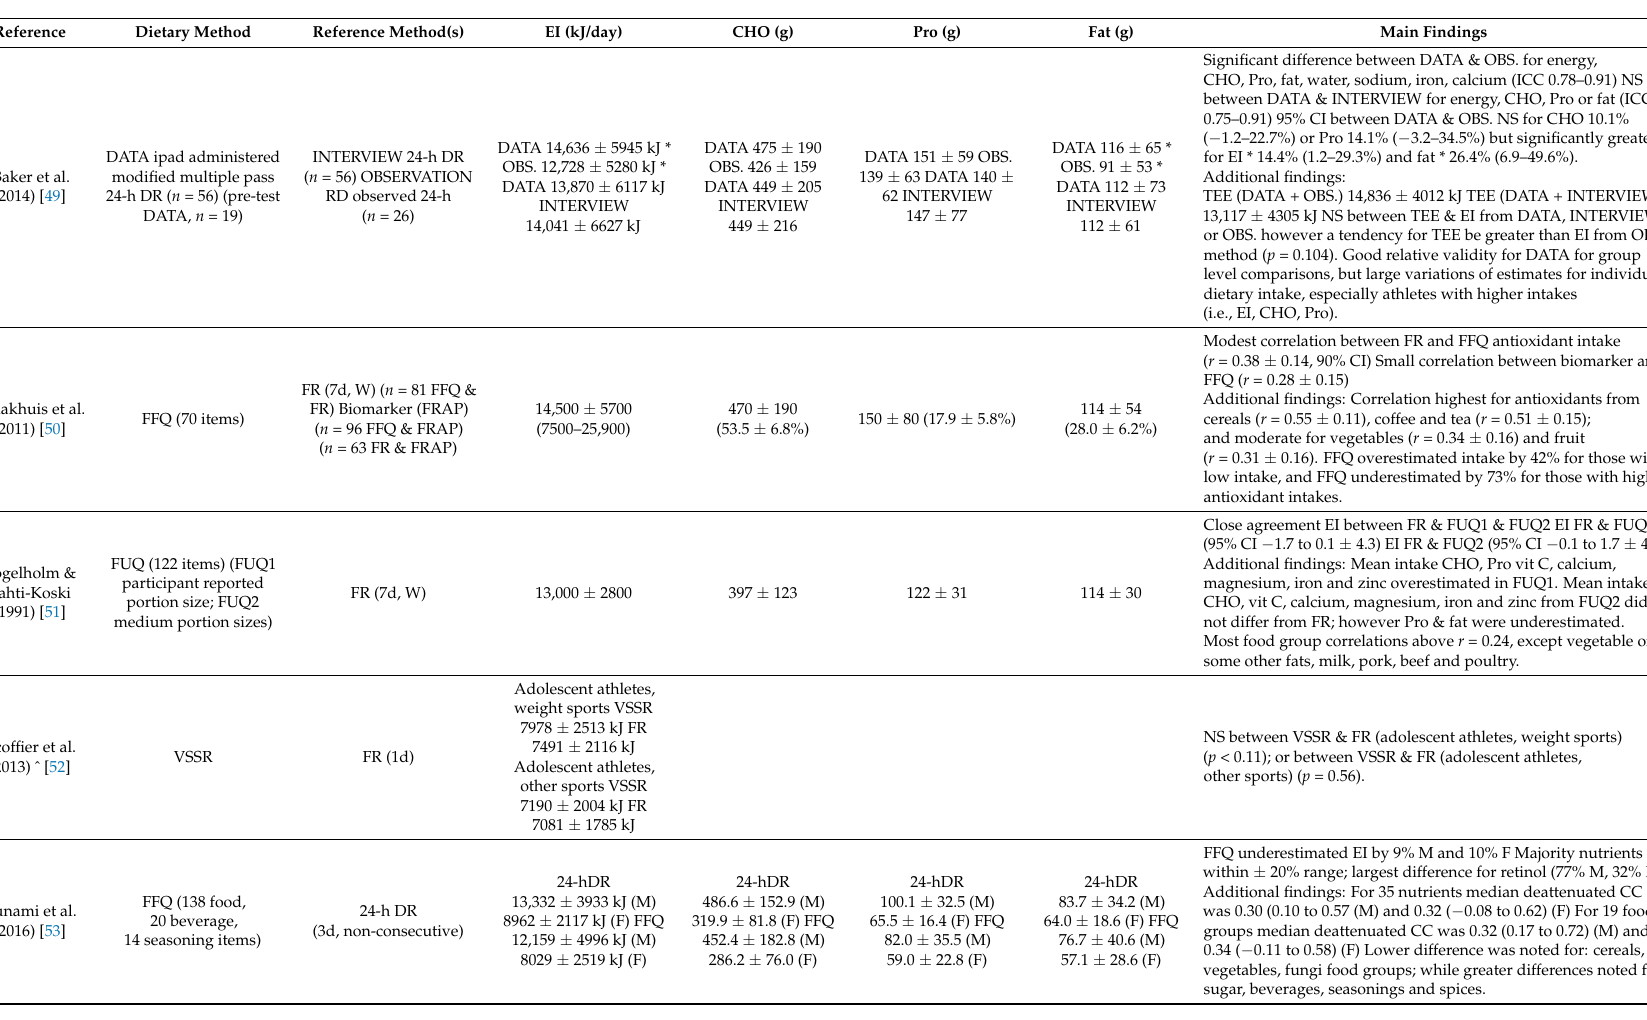
Table 4. Studies comparing reported dietary intake as measured by two or more methods of dietary